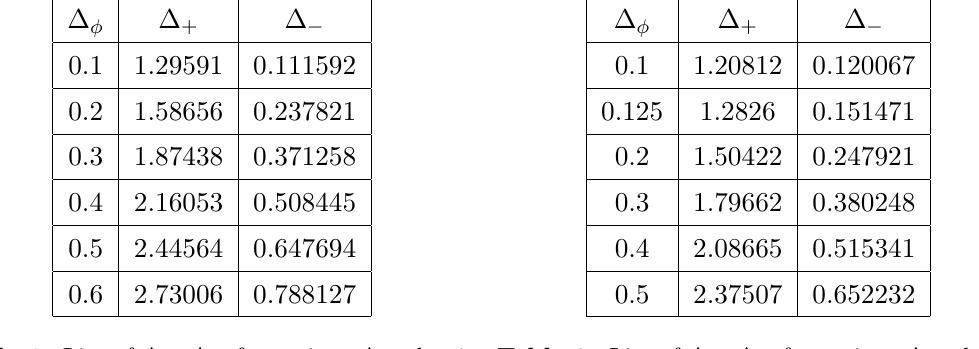
Table 1. List of (cid:1) + ; (cid:1) (cid:0) for various (cid:1) (cid:30) , d =